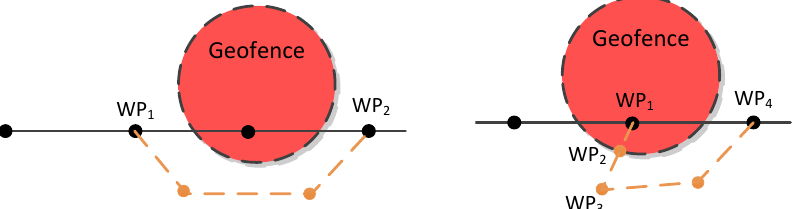
Figure 10. ( Left ), a UAS with a flight plan crossing a geofence. The last waypoint of its flight plan before entering the geofence (WP 1 ) and the first waypoint after leaving it (WP 2 ) are obtained, and this portion of the flight plan is replaced by an alternative route (dashed line). ( Right ), a UAS that is inside a geofence. The escape point (WP 2 ) is that on the geofence’s border closest to the UAS (WP 1 ). From WP 3 , which is already at a safety distance from the geofence, to the first point of the flight plan after leaving the geofence (WP 4 ), an alternative route avoiding the geofence is inserted to modify the original flight plan.